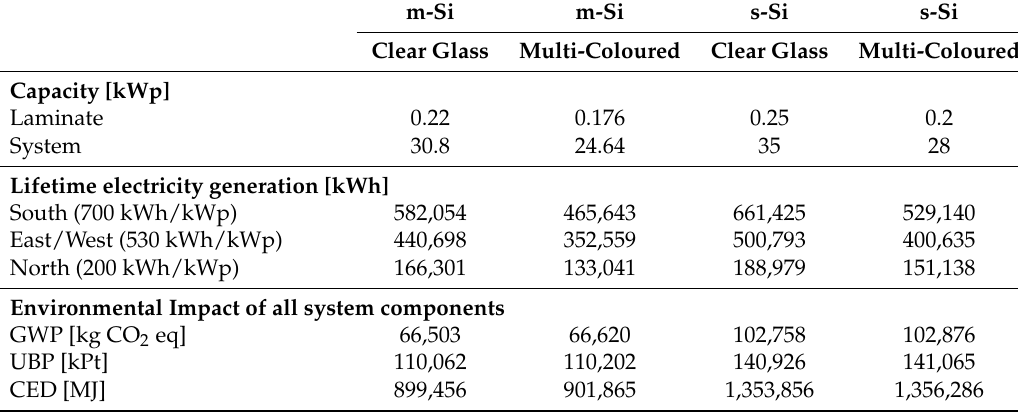
Table A1. Lifetime electricity production and environmental impact by system configuration and orientation. If a configuration outperforms the reference (the Swiss grid electricity mix), it is marked in